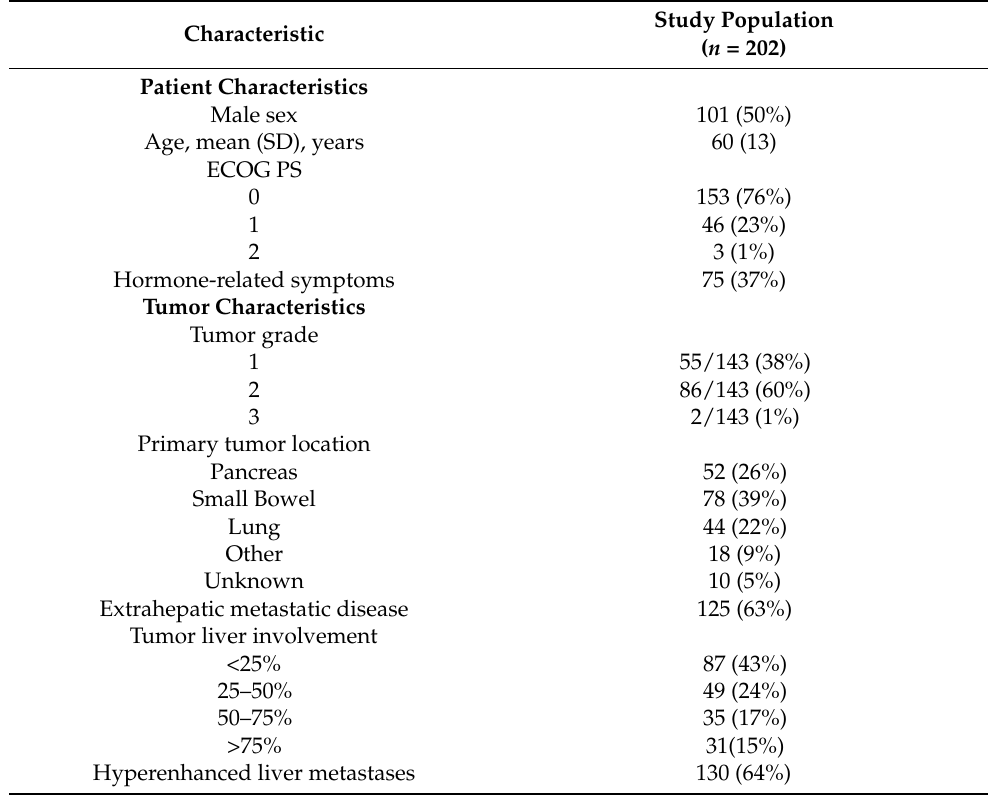
Table 1. Patient and tumor